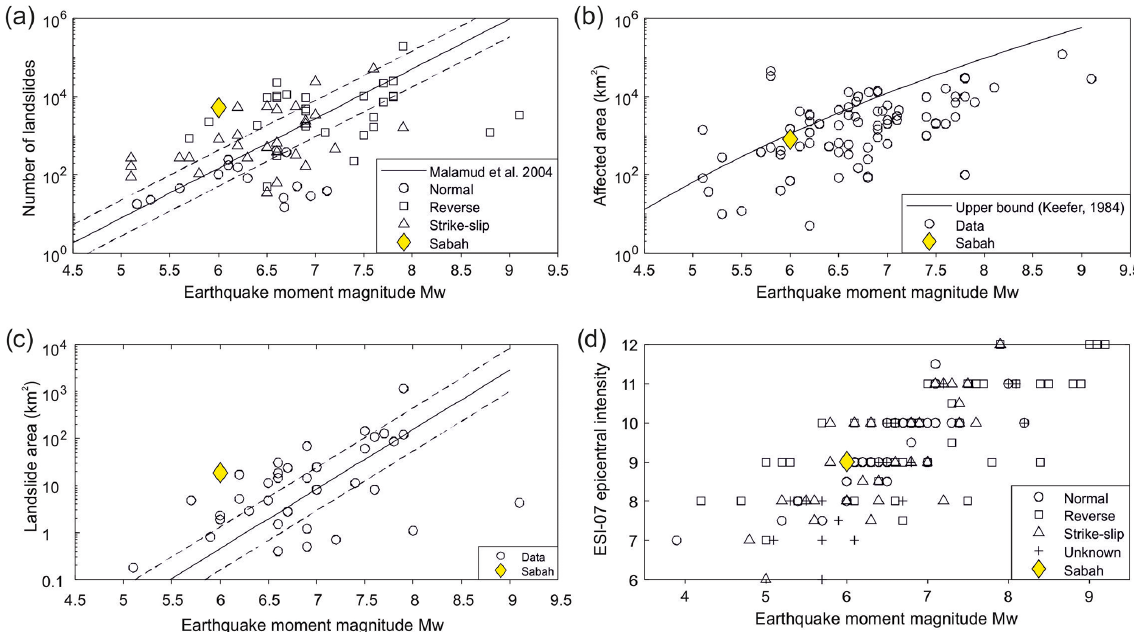
Figure 7. Comparison of the Sabah earthquake with global studies: (a) number of landslides vs. M w , regression is Eq. (2); (b) affected area vs. M w , upper bound after Keefer (1984); (c) landslide area vs. M w , regression is Eq. (3); (d) ESI-07 epicentral intensity. Table 3. Median values of LND for each ESI-07 intensity degree, obtained using the area–volume scaling relations of Table 1. ESI-07 Guzzetti Larsen Larsen Larsen Xu Benjamin Caputo (all) (bedrock) (soil) VI 1 1 1 2 1 1 1 VII 3 3 3 5 2 VIII IX 29 27 26